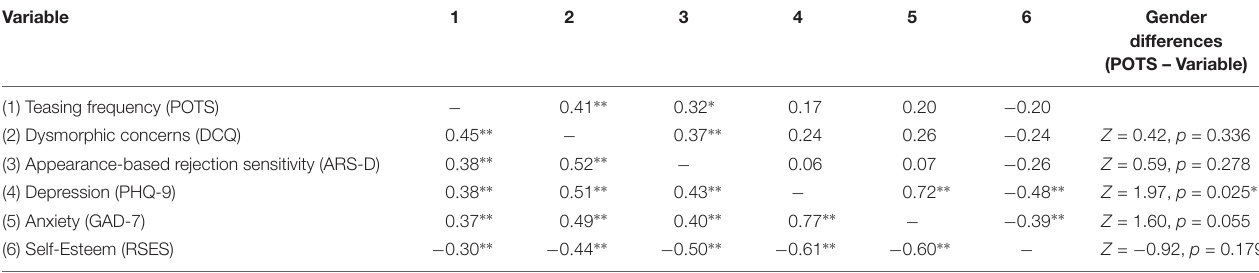
TABLE 3 | Gender-specific correlations between teasing, body image, and mental health variables and gender differences in correlations. Variable